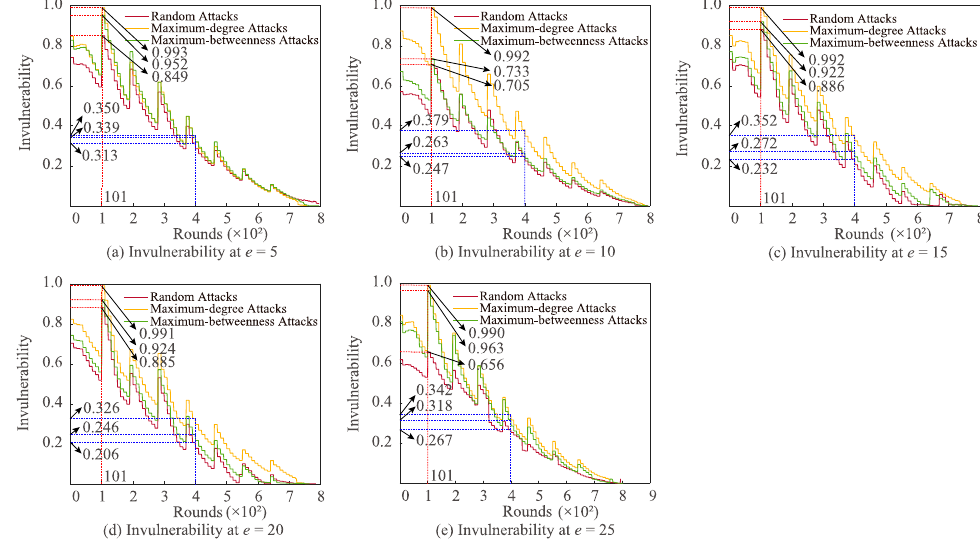
Figure 2. Relationships between differing e and invulnerability under distinct attacks.